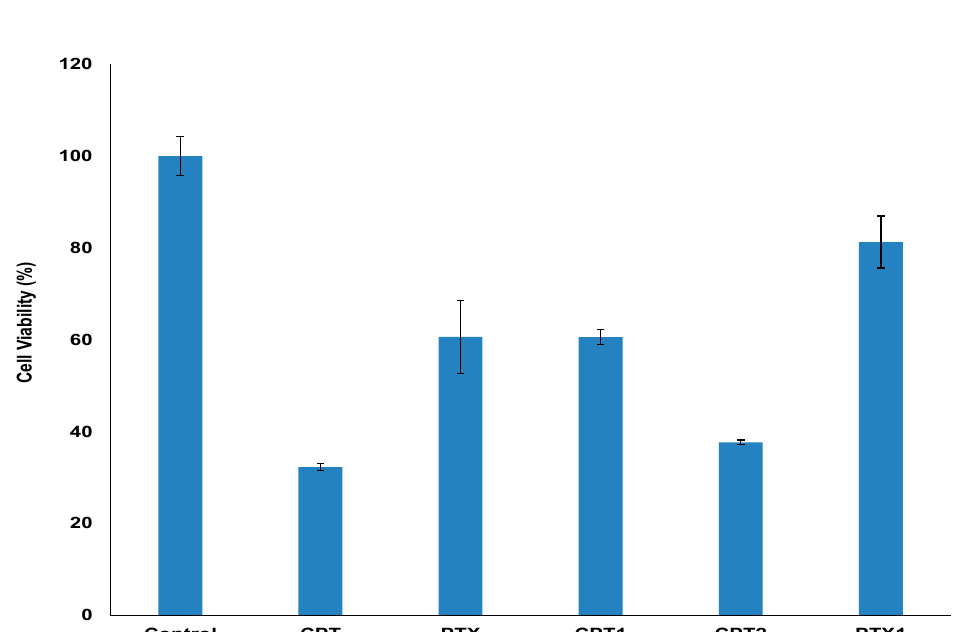
Figure 1. The antiproliferative activity of camptothecin (CPT), paclitaxel (PTX), and their conjugates at (5 µM) concentration in MCF-7 cells after 72 h incubation.